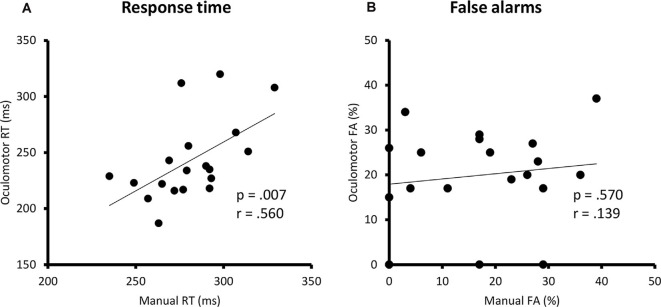
Correlation analyses between the manual and oculomotor RTs in ms (A) and between the manual and the oculomotor FA in percentage (B). Linear regression lines, p-values, and Pearson correlation coefficients are represented. RT, response time; ms, milliseconds; FA, false alarm.